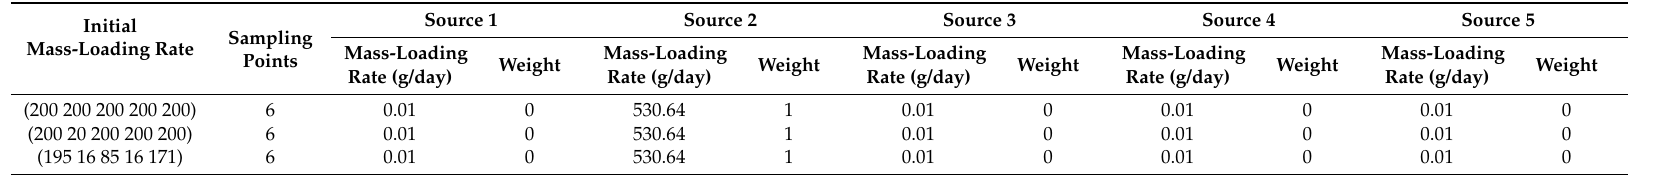
Table 5. Sensitivity analysis results of the initial mass-loading rate for the pollution source identification.